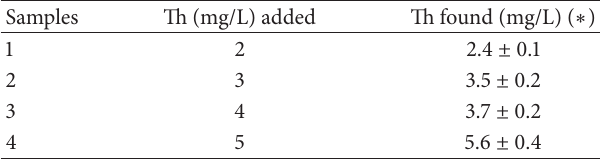
Table 3: Determination of Th(IV) in the synthetic